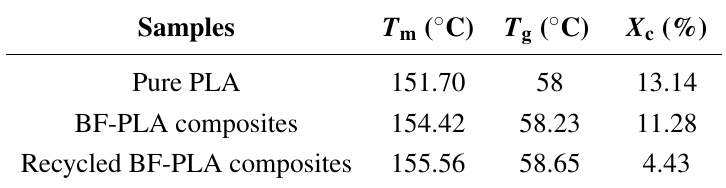
Figure 3. DSC thermograms of recycled BF-PLA composite, BF-PLA composite and virgin PLA. Table 2. DSC numerical data of BF-PLA composites after the recycling process. Table 2. DSC numerical data of BF-PLA composites after the recycling process. Samples